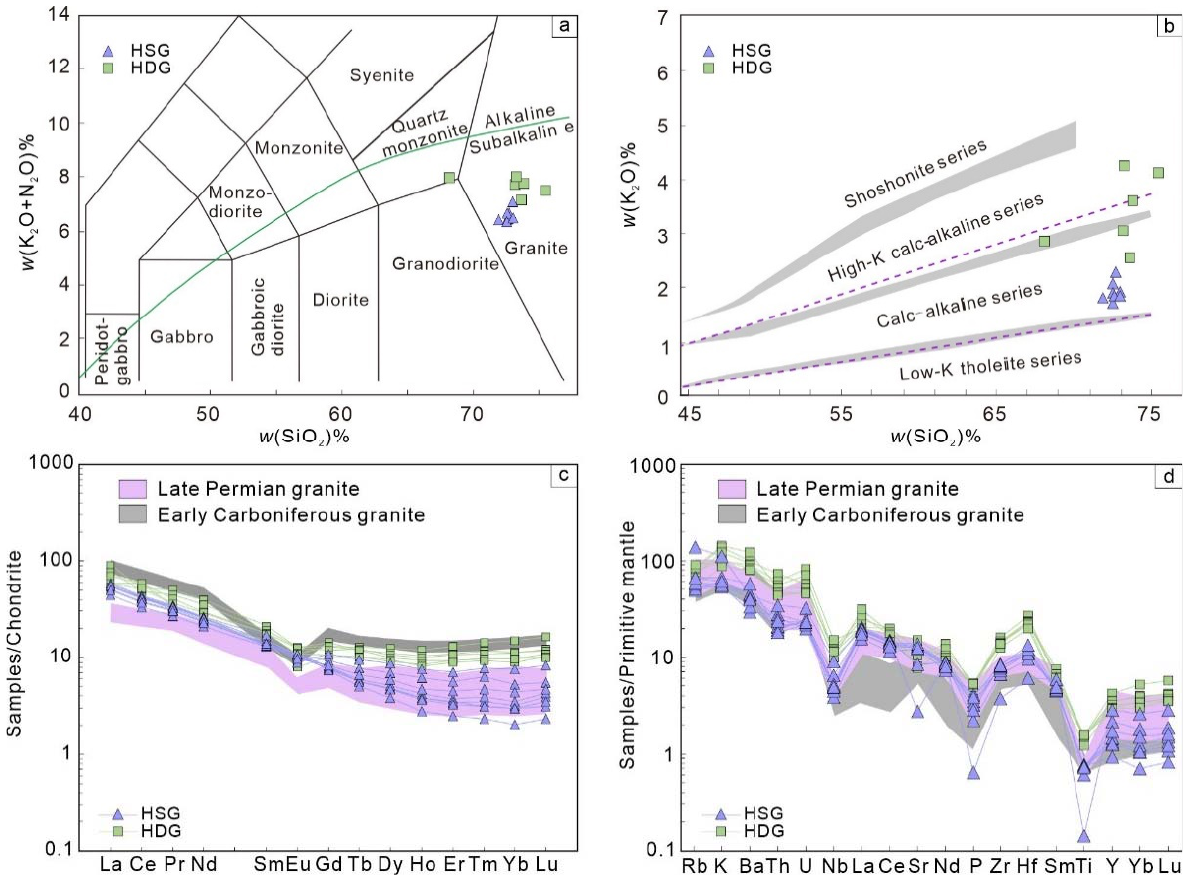
Figure 7. ( a ) Total alkali (Na 2 O + K 2 O) versus silica (SiO 2 ) (TAS) diagram, modified after Middlemost [86]. ( b ) SiO 2 vs. K 2 O diagram. ( c ) Chondrite ‐ normalized REE distribution. ( d ) Primitive mantle ‐ normalized trace element diagrams. Normalizing factors are from Sun and McDonough [87]. The data of Late Permian granite are from Muhtar et al. [49], and the data of Early Carboniferous granite are from Du et al. [88].